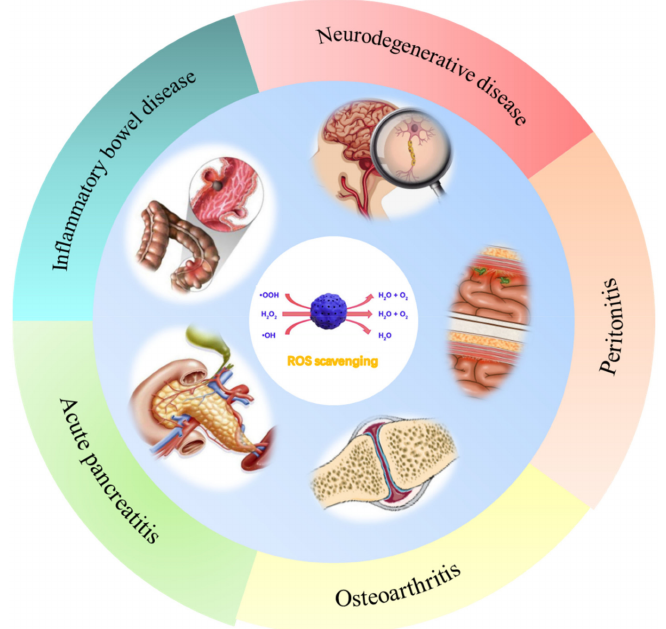
Figure 4. Summary of different applications of PBNPs in Acute pancreatitis, Osteoarthritis, Peritonitis, Neurodegenerative diseases, and Inflammatory bowel